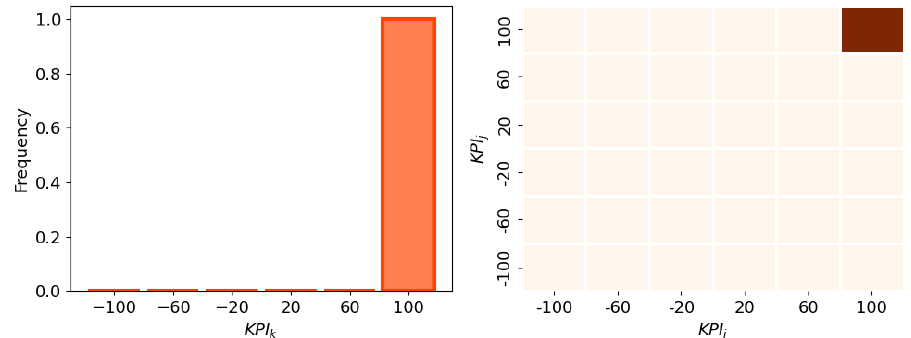
Figure 7. Univariate histogram associated with the ideal store ( left ): KPI values are on the x-axis, and their relative frequencies are on the y-axis. Bivariate histogram associated with the ideal store ( right ): KPI values related to 𝐾𝑃𝐼 𝑖 and 𝐾𝑃𝐼 𝑗 are on the x-axis and y-axis, respectively, and each bin is colored by their relative frequencies.